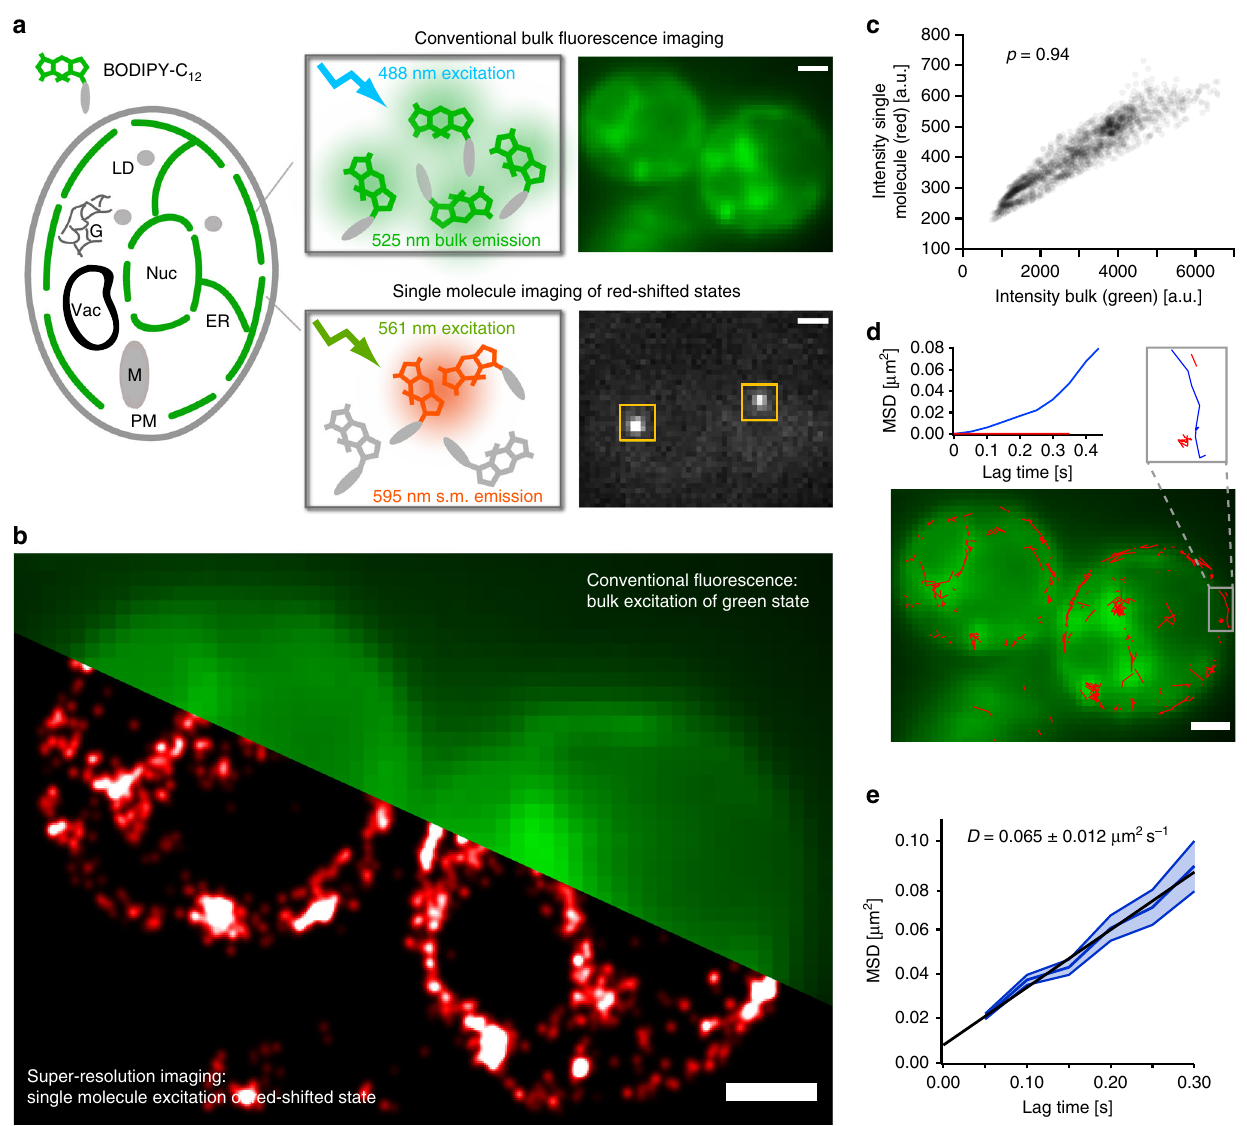
Fig. 1 SMLM and tracking with transient red-shifted D II -states of conventional BODIPY conjugates. a BODIPY fl uorophores exist as various conjugates that label speci fi c compartments within cells. BODIPY-C 12 is a fatty acid analog that localizes to the ER of living yeast cells when excited at 488nm in the conventional fl uorescence microscopy mode (green, upper). When excited at 561nm, bright and red-shifted single-molecule fl uorescence signals appear and disappear throughout the cell (white, lower). b The bright single-molecule fl uorescence can be used for SMLM to obtain a ~tenfold higher resolution image of the fatty acid distribution within the cell (red). c The pixel intensities of the conventional fl uoresce image of BODIPY-C 12 excited at 488nm correlate well with the single- molecule signal excited at 561nm and averaged over 800 frames (Pearson ’ s ρ = 0.94, number of cells = 2, number of data points = 2128), con fi rming the common origin of the two signals. d The detected single-molecule signal of D II -BODIPY states lasts long enough to track fatty acid analogs (red traces). Different mobile (blue) and immobile (red) species can be discriminated. e The average mean square displacement vs. time of fatty acid analogs of 150 traces each lasting for at least 3 acquisition frames (0.15s) results in an average diffusion coef fi cient of 0.065±0.012 µ m 2 s − 1 (error band: s.e.m., scale bars: 1 µ